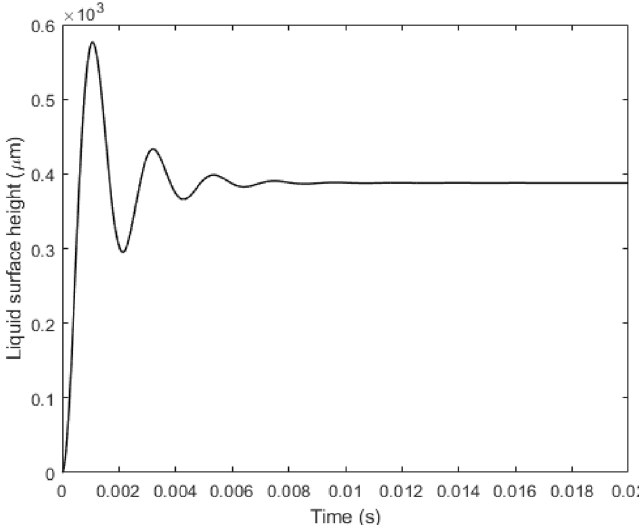
Figure 5. Observed liquid meniscus oscillation at the first 0.008 s in our theoretical